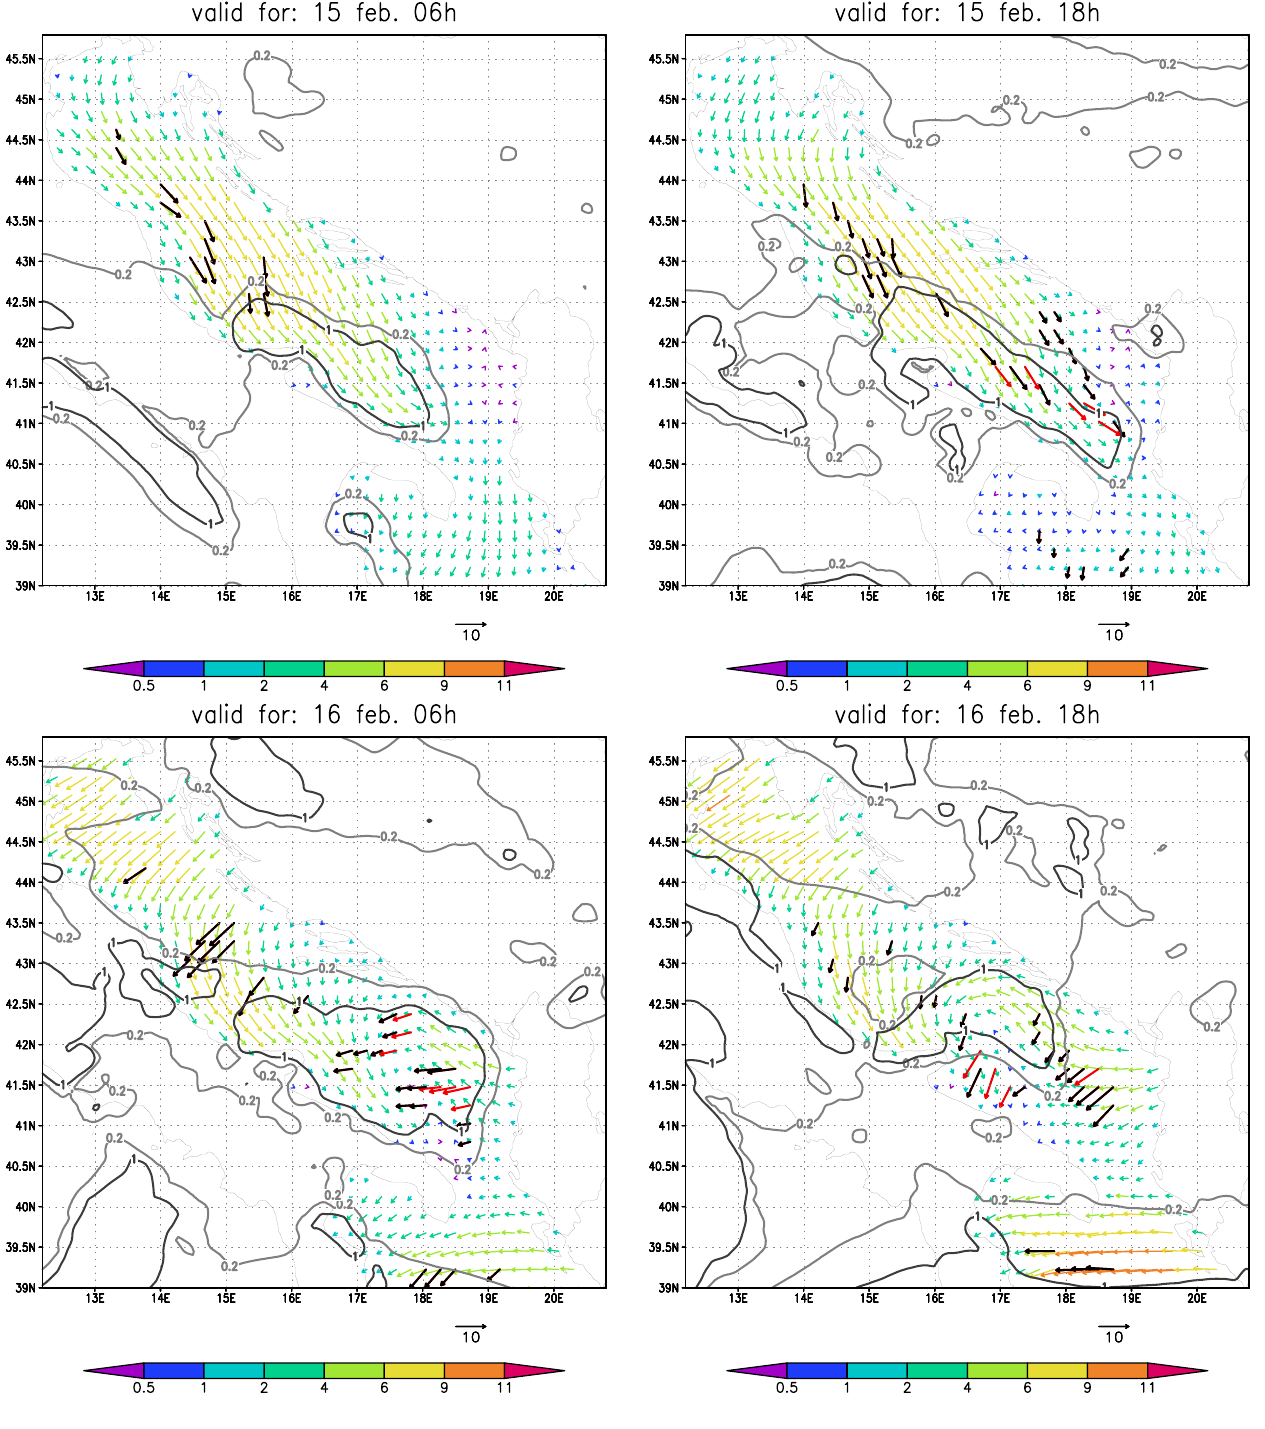
Fig. 12. Same as Fig. 11 except for 15–16